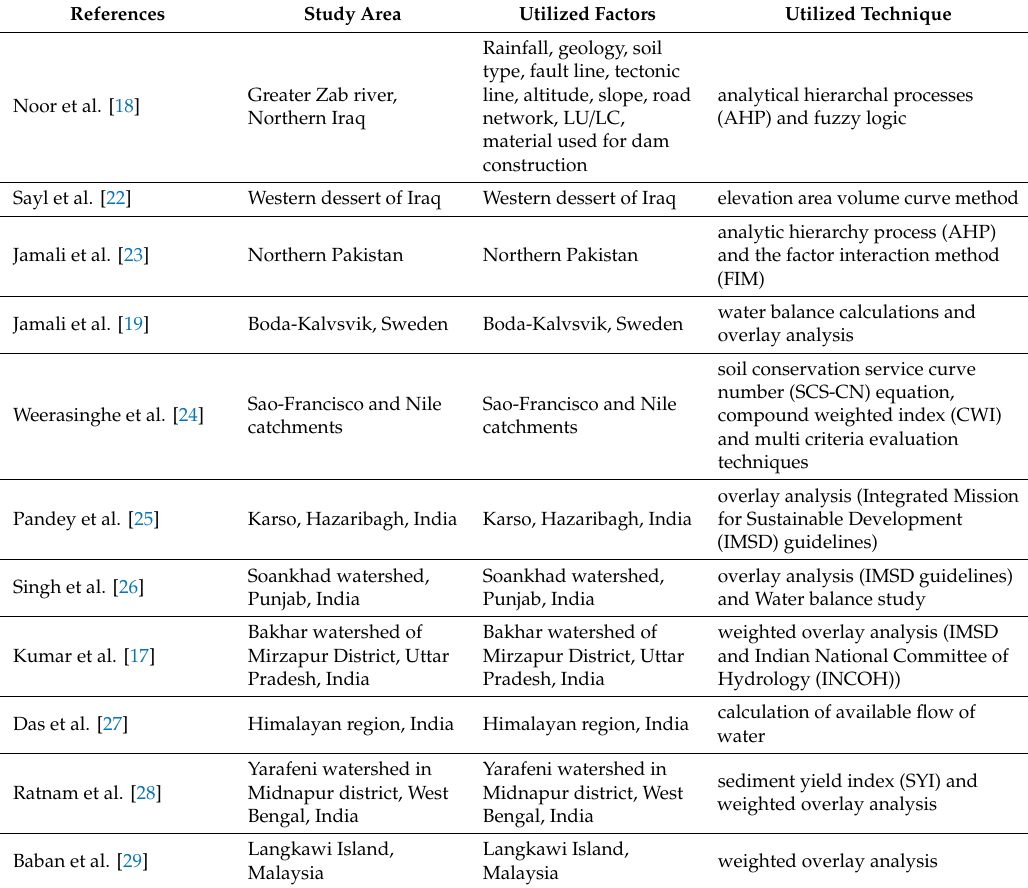
Table 1. Review of recent dam site suitability